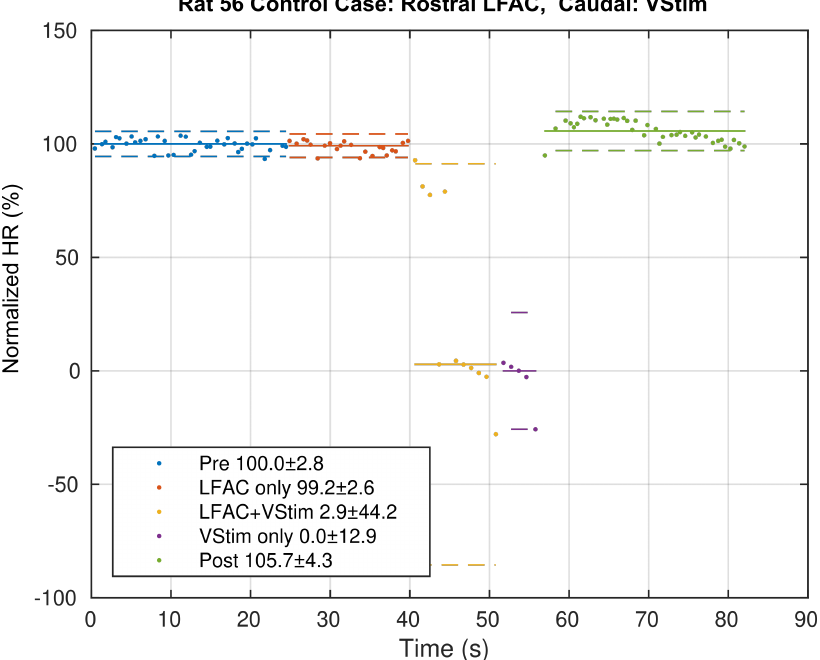
Figure 5. Example of the Normalized HR (estimating the RR rate derived percent block) as a function of epoch for the control case where LFACb is presented at the RE and vagal stimulation at the CE. Note that the ’LFACb+VStim’ epoch does not show block, suggesting that the mechanism of action is not due to electrode or waveform interactions. The solid lines indicate medians and the dashed straight lines indicate one standard deviations. Legend values are % Block ±